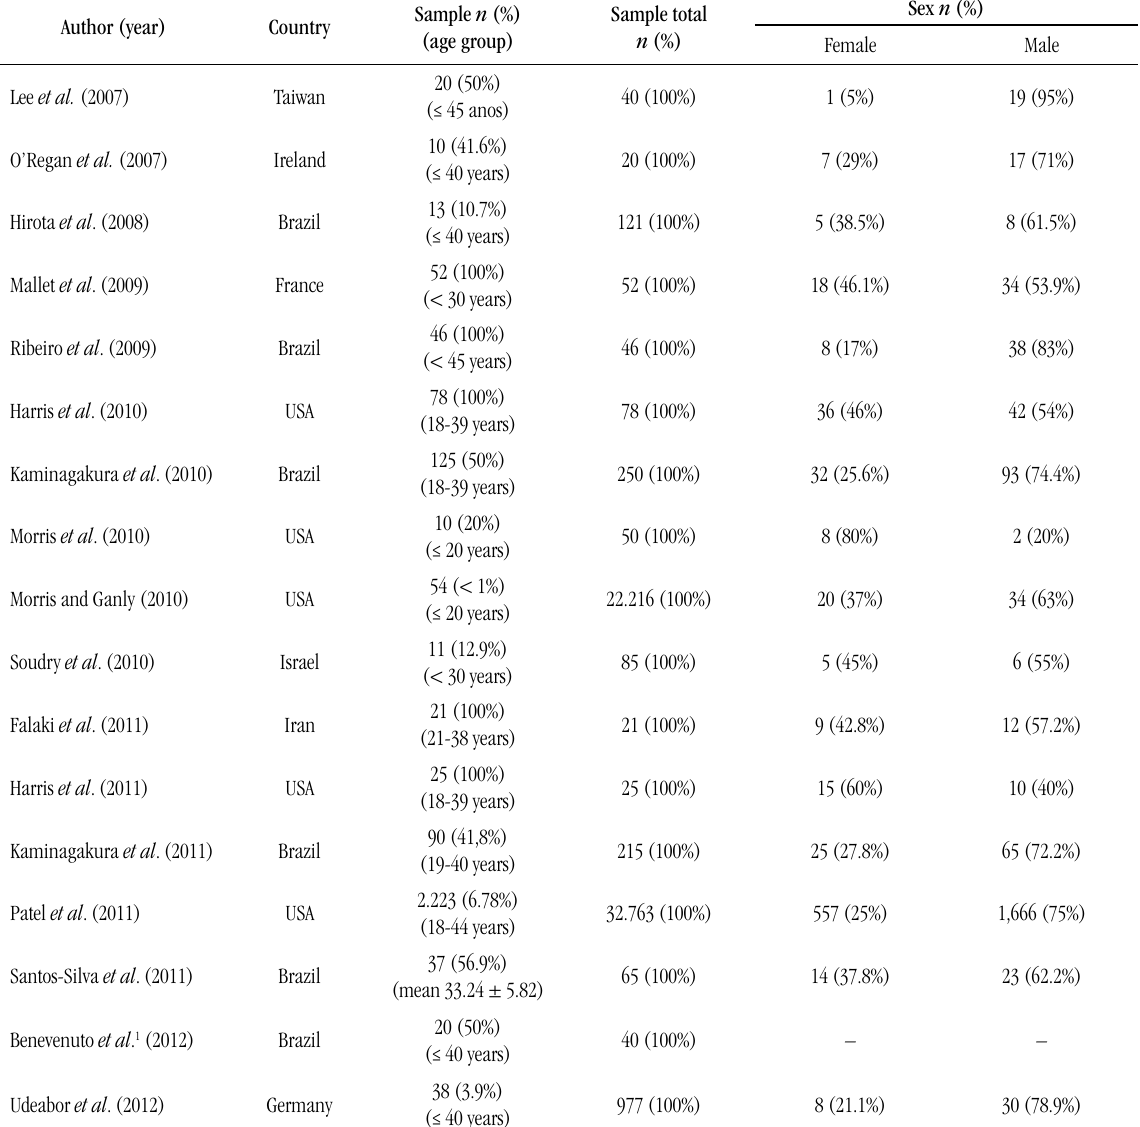
tABLE 1 – Distribution of the 17 studies on oral squamous cell carcinoma in young patients, selected from PubMed between 2007 and 2012, according to author, year of publication, country, sample, age group, and